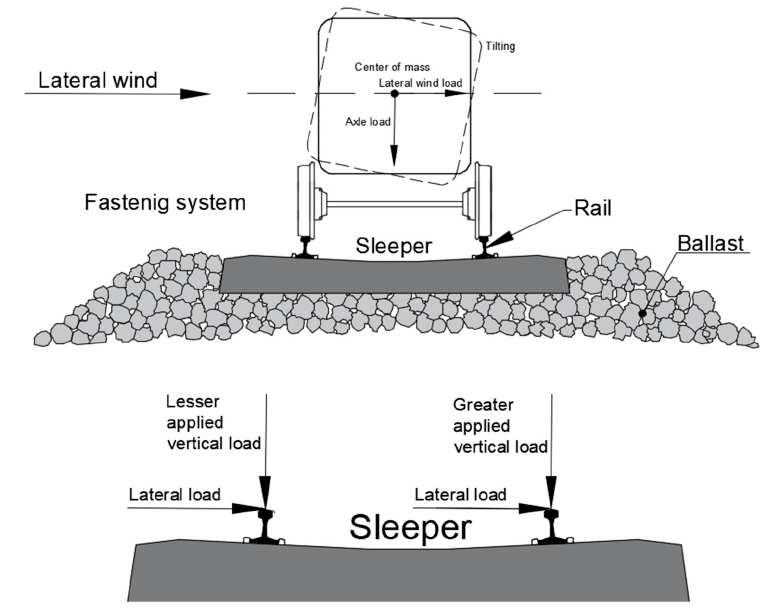
Figure 9. Force transfer of the railway under later wind loads.